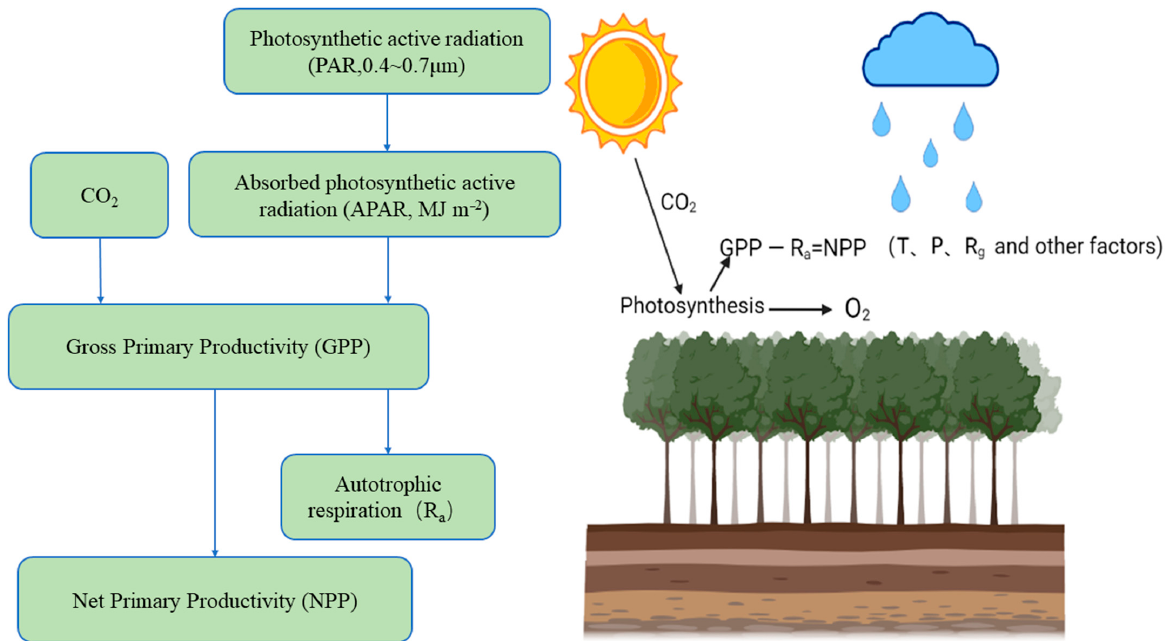
Figure 1. NPP mode diagram. Solar radiation irradiates vegetation and is absorbed and